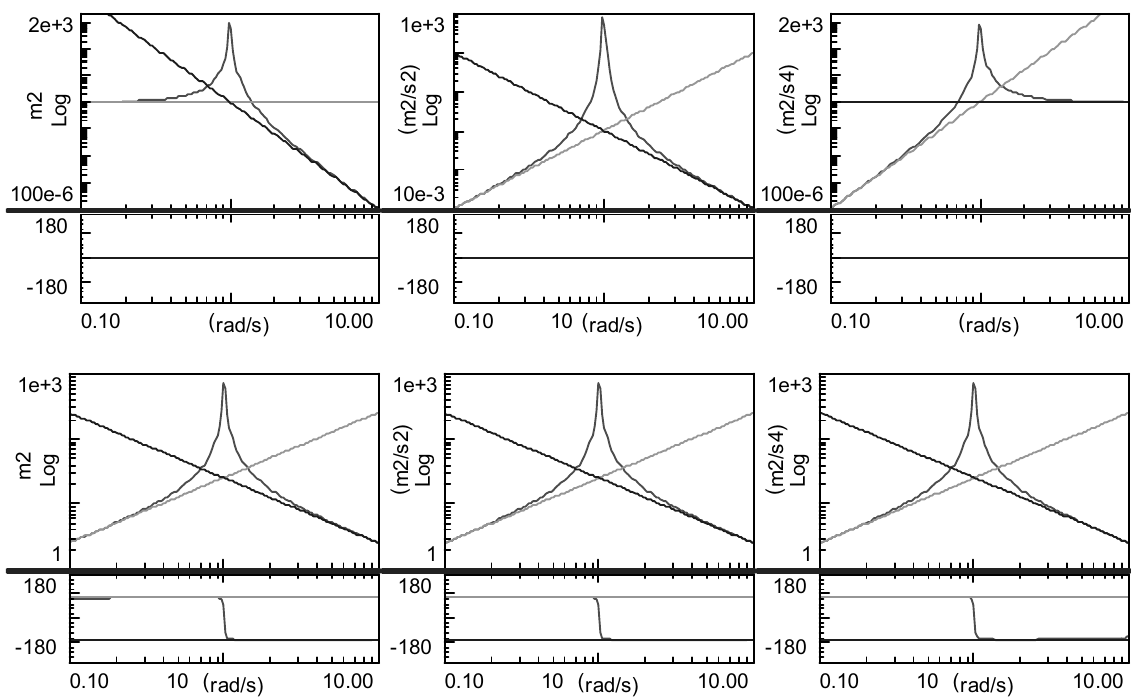
Fig. 4. SDOF response to white noise input. (Top) Full spectrum; (Bottom) half spectrum. (Left) displacement; (Middle) velocity; (Right) acceleration response. The upper and lower residuals can be represented by straight lines on a log-log